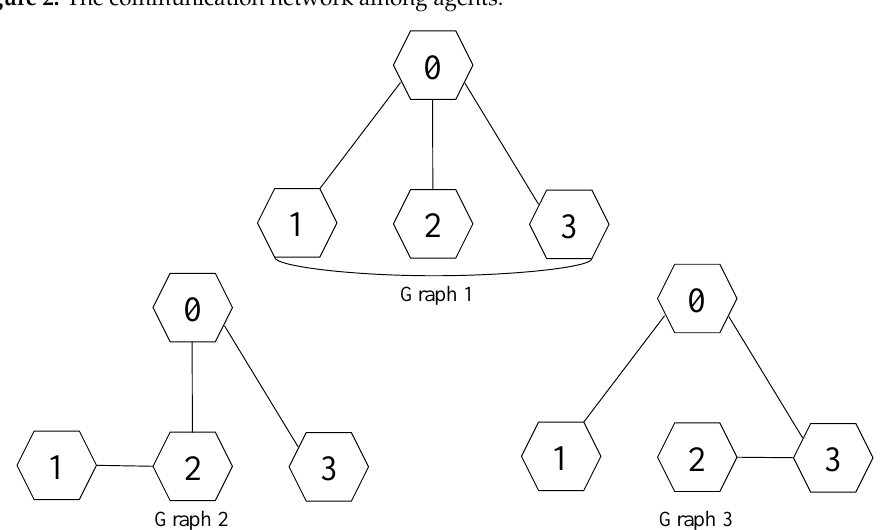
Figure 3. The communication network among agents under DoS